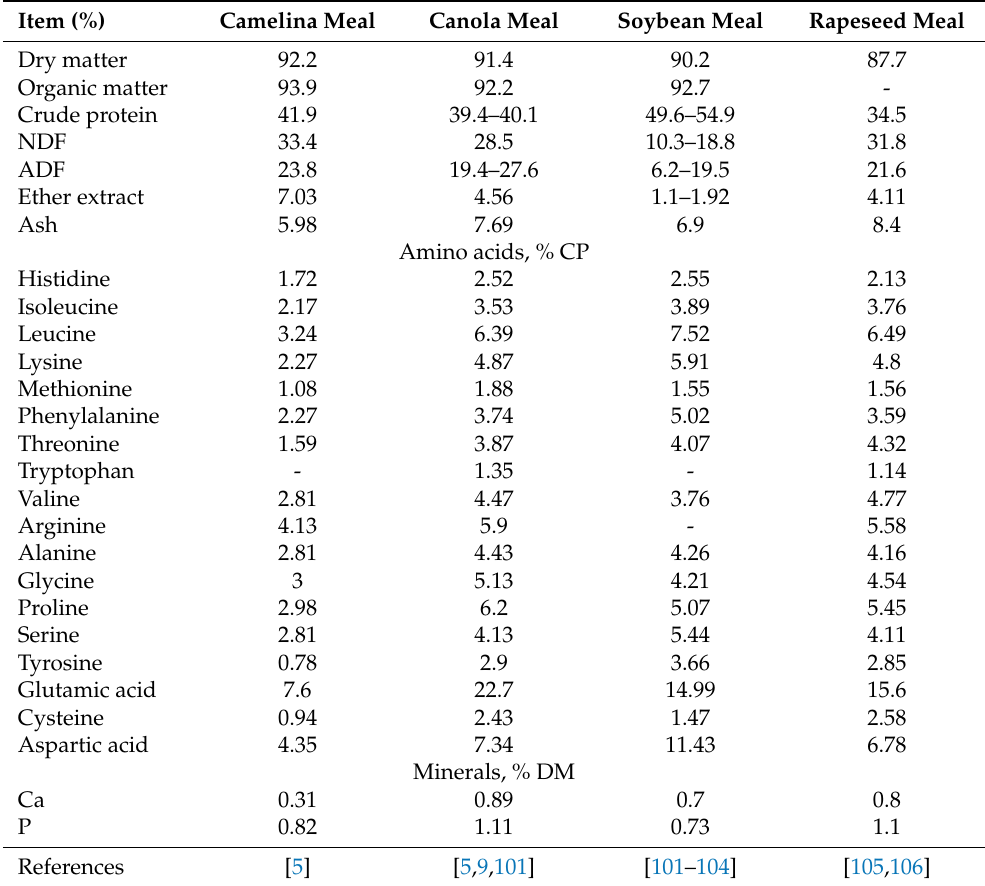
Table 5. Comparison of camelina meal with other oilseed